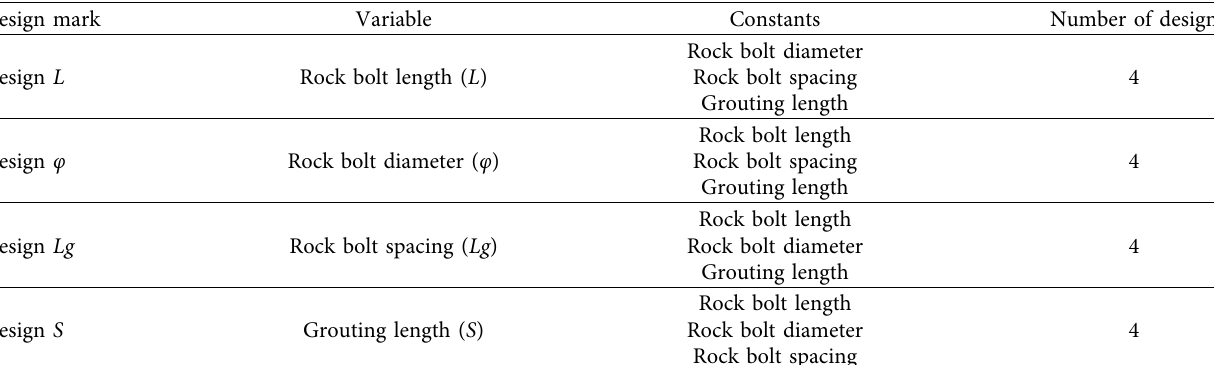
Figure 6 and Table 5 show that Design L ( L = 1800 mm and L = 2000 mm, respectively) have the widest distribution of tensile failure zones. By applying an